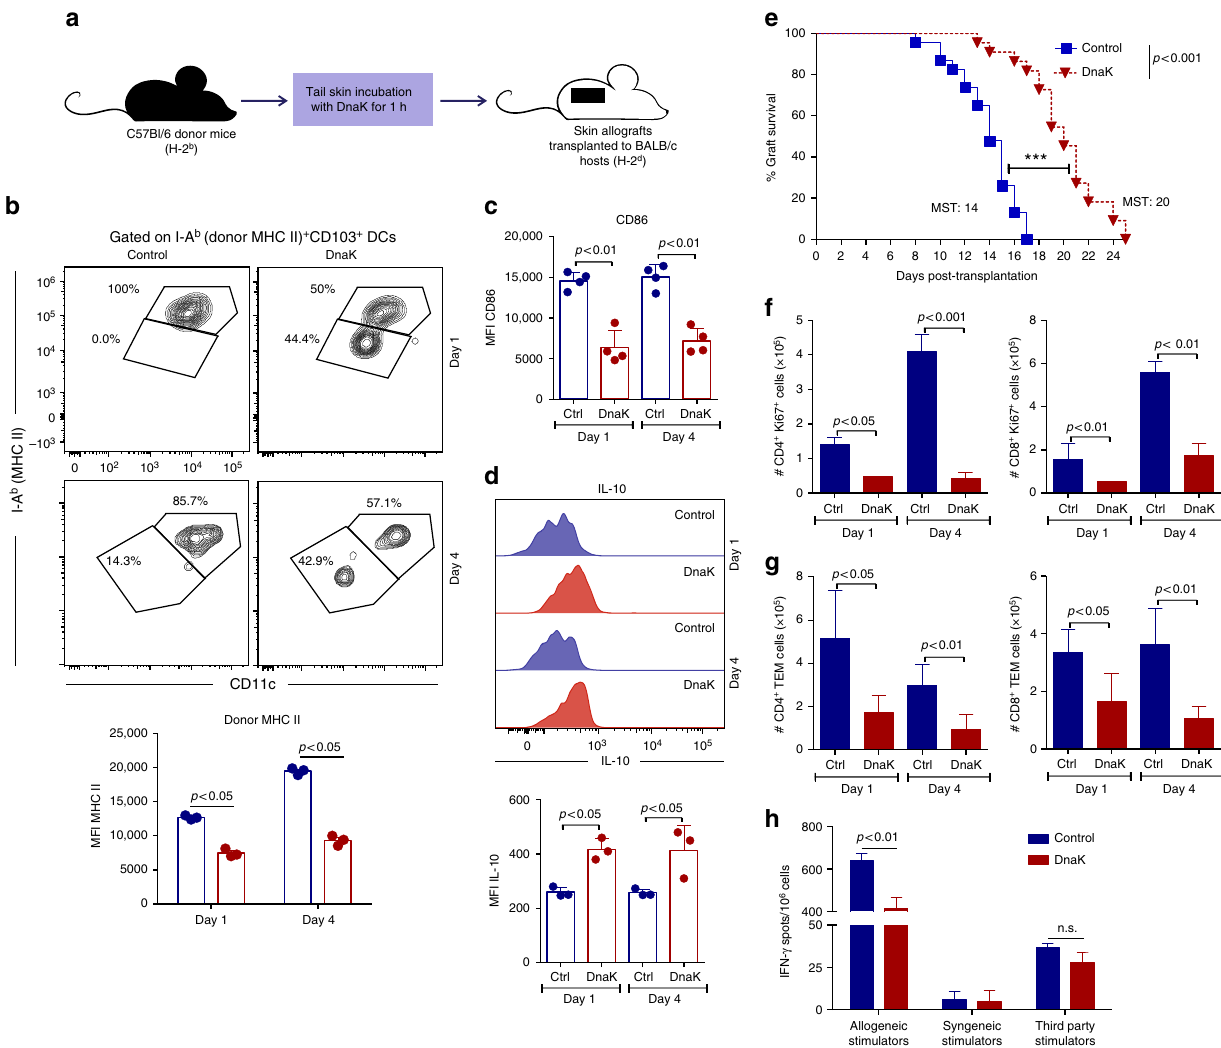
Fig. 3 In situ skin treatment with DnaK prior to the transplant decreases donor MHC II expression in cross-dressed host DCs and improves allograft survival. Skin allografts from B6 mice (H-2K b /I-A b ) were immersed in PBS solution with or without DnaK for 1 h, followed by transplantation into fully MHC mismatched BALB/c hosts (H-2K d /I-A d ). a Schematic view of the experimental design. b MHC II, c CD86 and d IL-10 expression in dLN cross-dressed host CD103 + DCs from mice that received DnaK-treated allografts or controls. Bar graphs represent the mean ± S.D. Statistics using t test. e Percent of graft survival after DnaK treatment ( n = 23/group). Mean survival time (MST). Statistic by long-rank test. Results are pooled from three experiments. f Numbers of CD4 + Ki67 + and CD8 + Ki67 + , and g CD4 + and CD8 + TEM cells from allograft dLNs harvested at day 1 and 4 post-transplant. Statistics using ANOVA with Tukey post-test ( n = 3 mice per group). Bar graphs represent the mean ± S.D. h T cells from allograft dLN were magnetically isolated and cultured with allogeneic (B6), syngeneic (BALB/c) or third party (C3H, H-2K k /I-A k ) irradiated splenocytes for 48 h in vitro in mouse IFN- γ -coated plates. IFN- γ production by T cells was measured by ELISPOT. Numbers of spots per million T cells ± S.D. in triplicates and pooled from three mice. Statistics using t test. Representative results of at least two independent